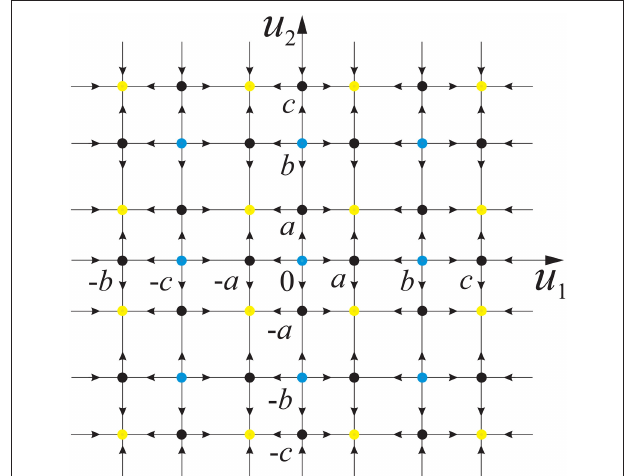
FIGURE 4 | Qualitative phase portrait of fast subsystem (7) for v 0 1 = v 0 2 = d = 0, a = 0.32, b = 0.79, and c = 1.166. The dots mark unstable nodes (blue), stable nodes (yellow), and saddles (black). The lines mark the separatrices of the saddle equilibrium